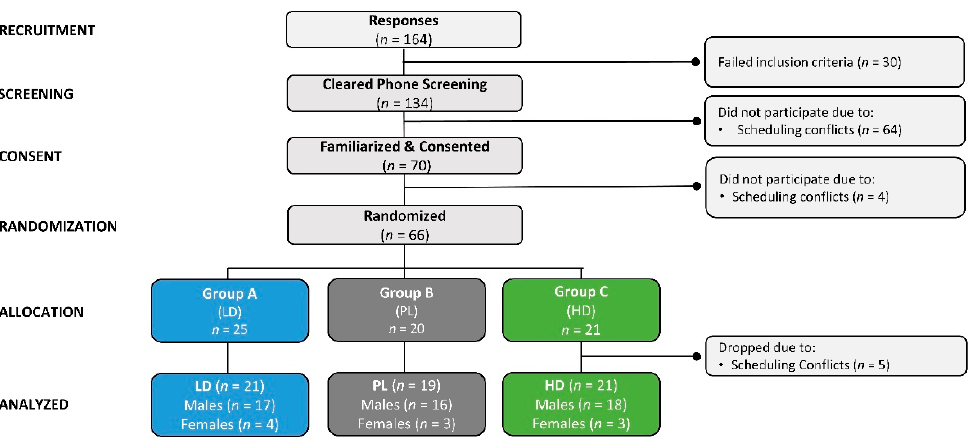
Figure 2. Consolidated Standards of Reporting Trials (CONSORT) chart for the placebo (PL), low-dose (LD), and high-dose (HD) groups.